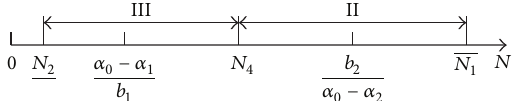
Figure 4: The optimal compensation mechanism in different